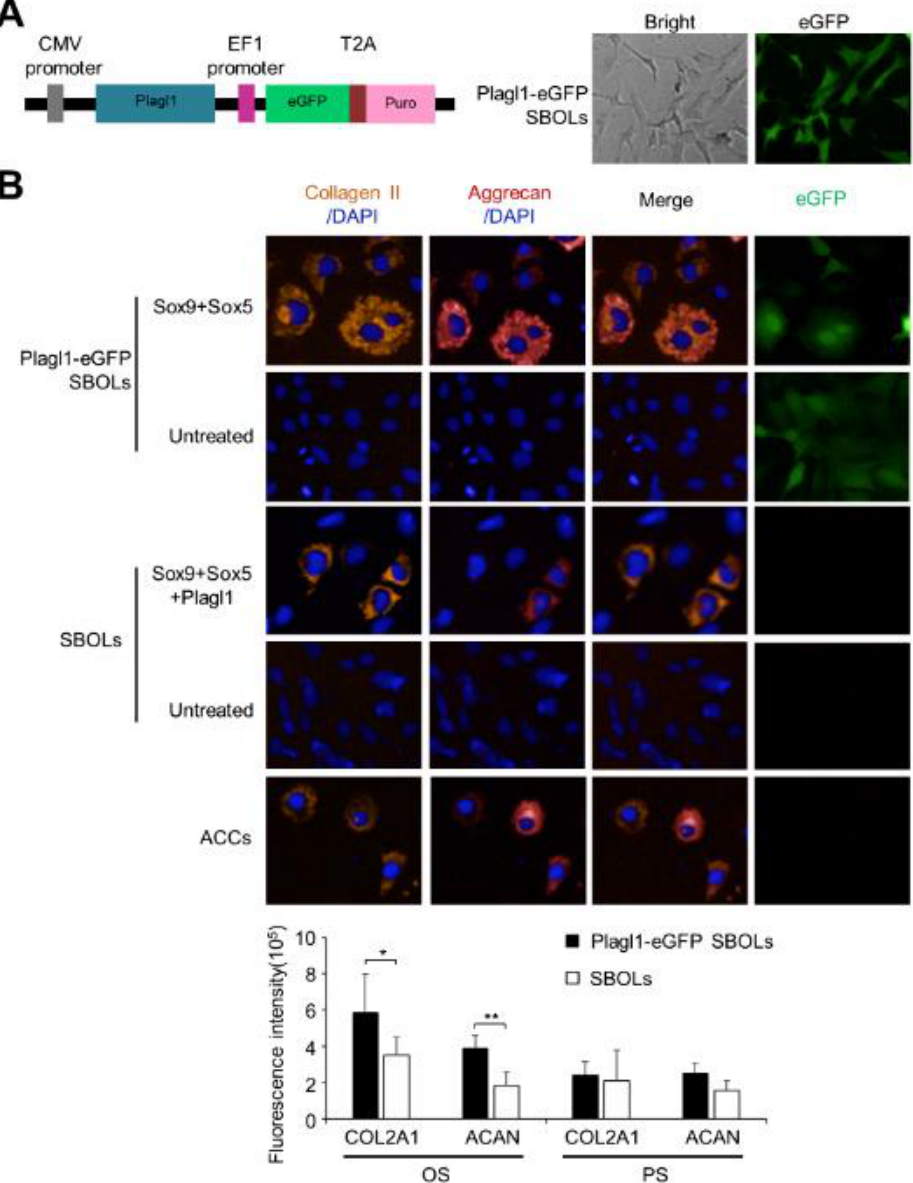
Figure 4. SBOs can be converted into two cell populations phenotypically resembling superficial and deeper zone ACCs, respectively. SBOLs were transduced with pCDH-Plagl1-eGFP lentiviruses and selected with 1.5 μg /mL puromycin for 2 w to generate Plagl1-eGFP SBOLs, resulting in more than 80% of eGFP-positive cells. Plagl1-eGFP SBOLs were then transduced with SOX9 and Sox5 lentiviruses at an MOI of 100. After 14 d culture, transfected cells were fixed for immunofluorescence analyses. ( A ) Establishment of Plagl1-eGFP SBOLs. Left panel : Schematic representation of the transgene. Right panel : Fluorescence microscopy of Plagl1-eGFP SBOLs. Magnification: 100 × . ( B ) Upper panel : Immunofluorescence microscopy of COL2A1 + , ACAN + and COL2A1 + ACAN + Plagl1-eGFP SBOLs after transduction with transcription factors indicated. Magnification: 200 × . Lower panel : Fluorescence intensity of COL2A1 and ACAN expression in oval shaped (OS) and flat polygonal shaped (PS) cells. * p < 0.05, ** p < 0.01.